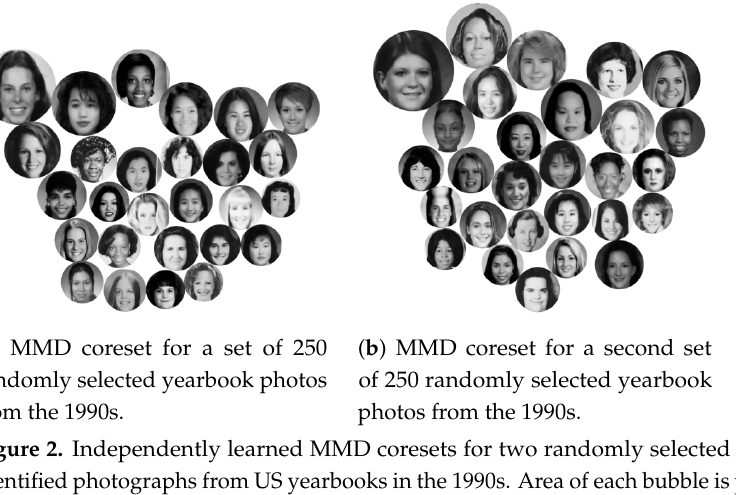
Figure 2. Independently learned MMD coresets for two randomly selected dataset of 250 female- identified photographs from US yearbooks in the 1990s. Area of each bubble is proportional to weight of the corresponding